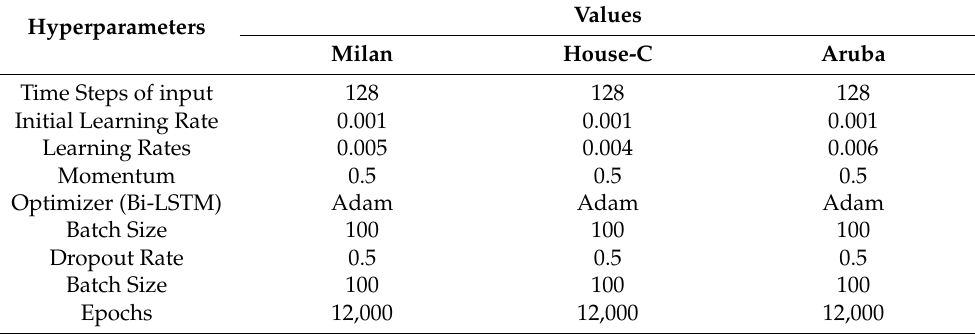
Table 2. Hyperparameter